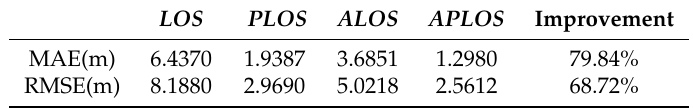
Figure 14. Sinusoidal tracking under constant ocean currents ( u = 1.5 m/s). ( a ) comparison of trajectory; ( b ) comparison of cross-track error; ( c ) comparison of look-ahead distance; ( d ) comparison of velocity and drift angle; ( e ) comparison of heading effect. Table 6. Performance metric of sinusoidal tracking under constant ocean currents ( u = 1.5